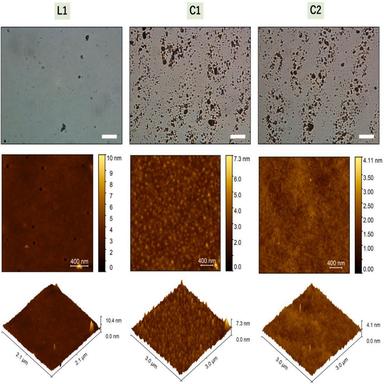
Photographs from optical microscope (scale bar 1 μm), AFM images and 3D surface representation of the studied L1, C1 and C2 thin films.